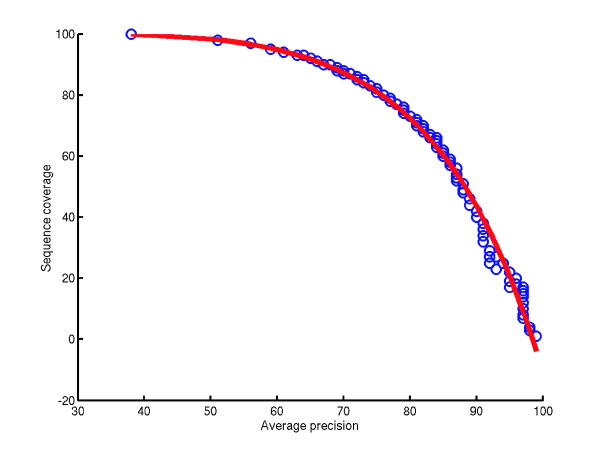
Precision against the sequence coverage: Average precision against sequence coverage for all 13-test organisms (circles). The red line denotes a fitting curve.